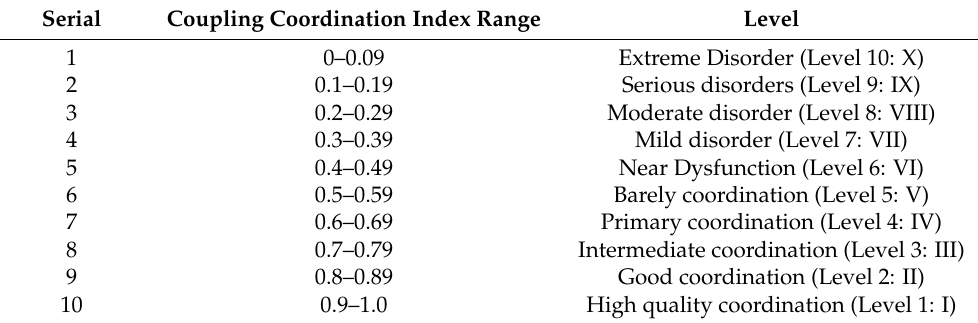
Table 3. Coupling degree of the coordination between land ecosystem services and economic–social